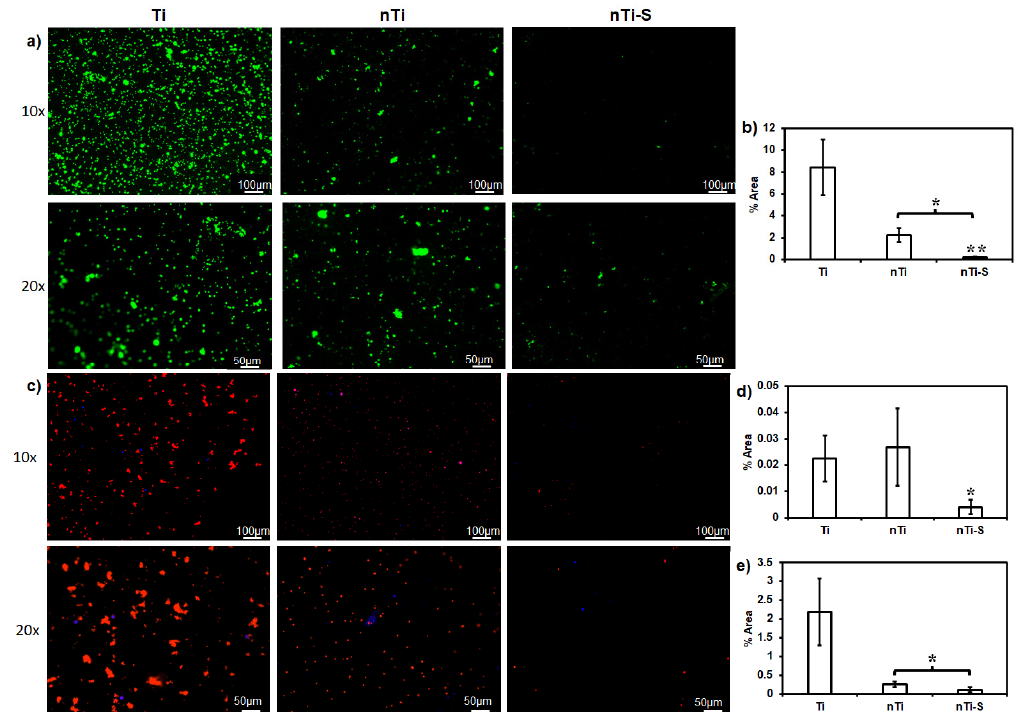
Figure 3. ( a ) Fluorescence images of live cells (platelets and WBCs) adhered to different surfaces. ( b ) Percentage area covered by adhered platelets and WBCs on different surfaces. ( c ) Fluorescence images of adhered platelets (red) and WBCs (purple) on different surfaces. ( d ) Percentage of the areas covered by adhered platelets (red) on different surfaces. ( e ) Percentage area covered by adhered WBCs (blue) on different surfaces. (* and ** p < 0.05; n min = 9.)